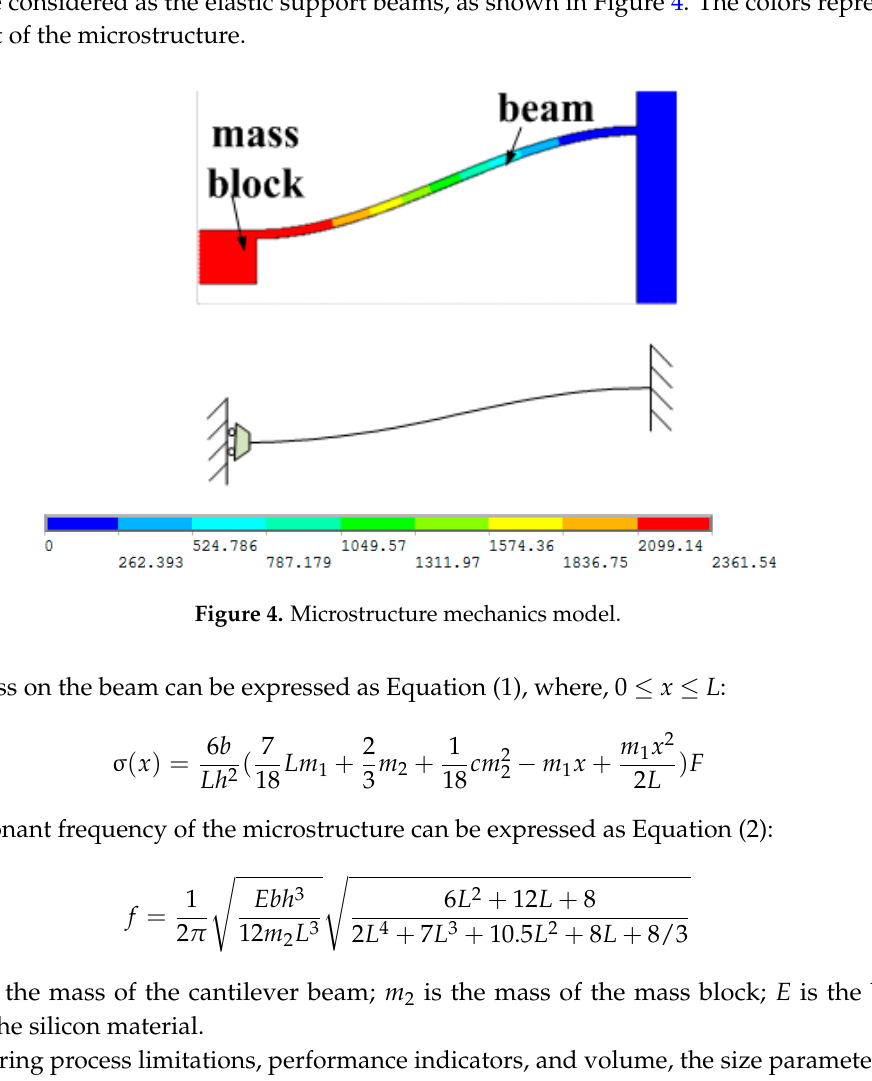
Figure 3. Schematic of the cantilever beam.